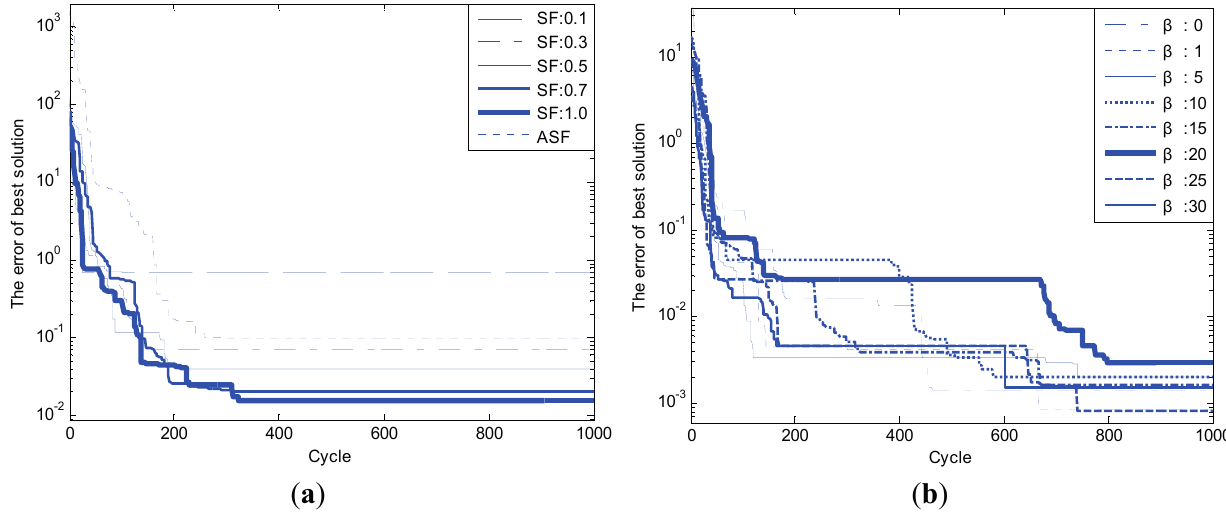
Figure 9. ( a ) Adjustment the search step; ( b ) Adjustment the calculation of transition